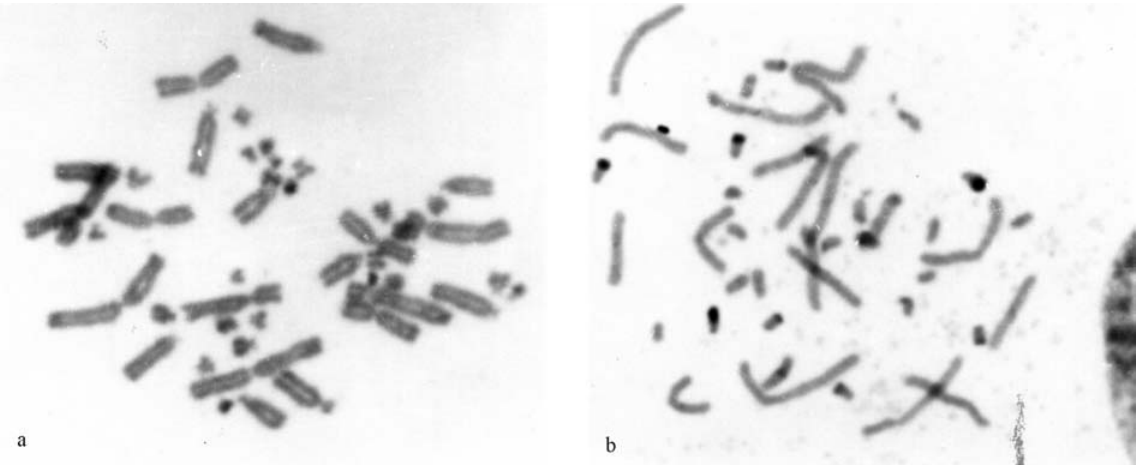
Figure 7 - C-banding patterns in metaphases of (a) Psilophthalmus paeminosus and (b) Tretioscincus oriximinensis